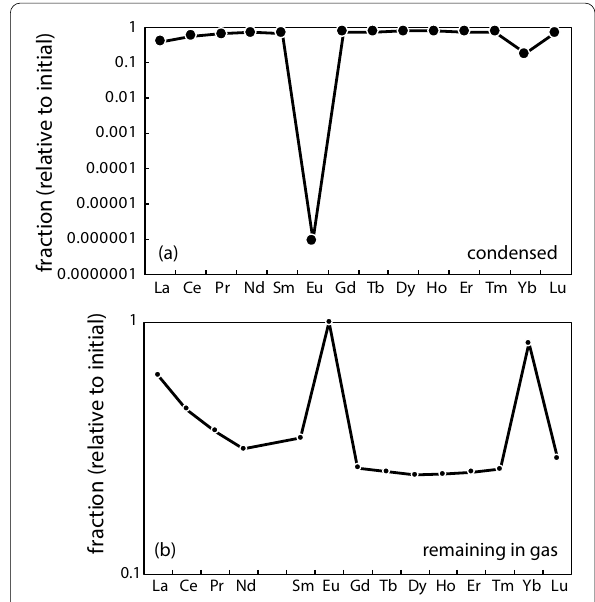
Fig. 6 Results of modeling of rare-earth element patterns during condensation in a reduced gas. a REE in the condensed phase. b REE in the residual. The resulting pattern b is similar to that found in oldhamite of primitive EH, suggesting an origin similar to that of fine-grained type II CAI of carbonaceous chondrites (Davis et al. 2018; see text for discussion). Here, a temperature of 10 K below oldhamite condensation temperature was considered (T cond Lodders and Fegley